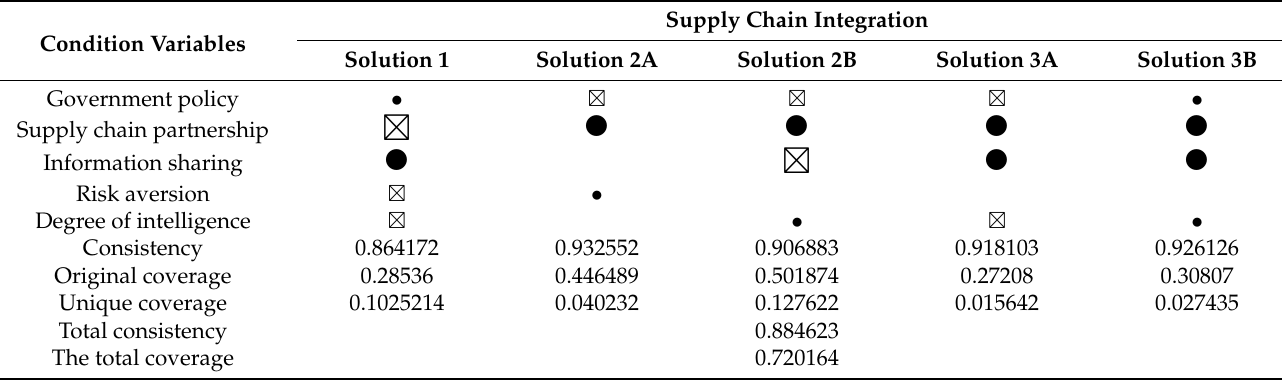
Table 7. Configuration of supply chain integration